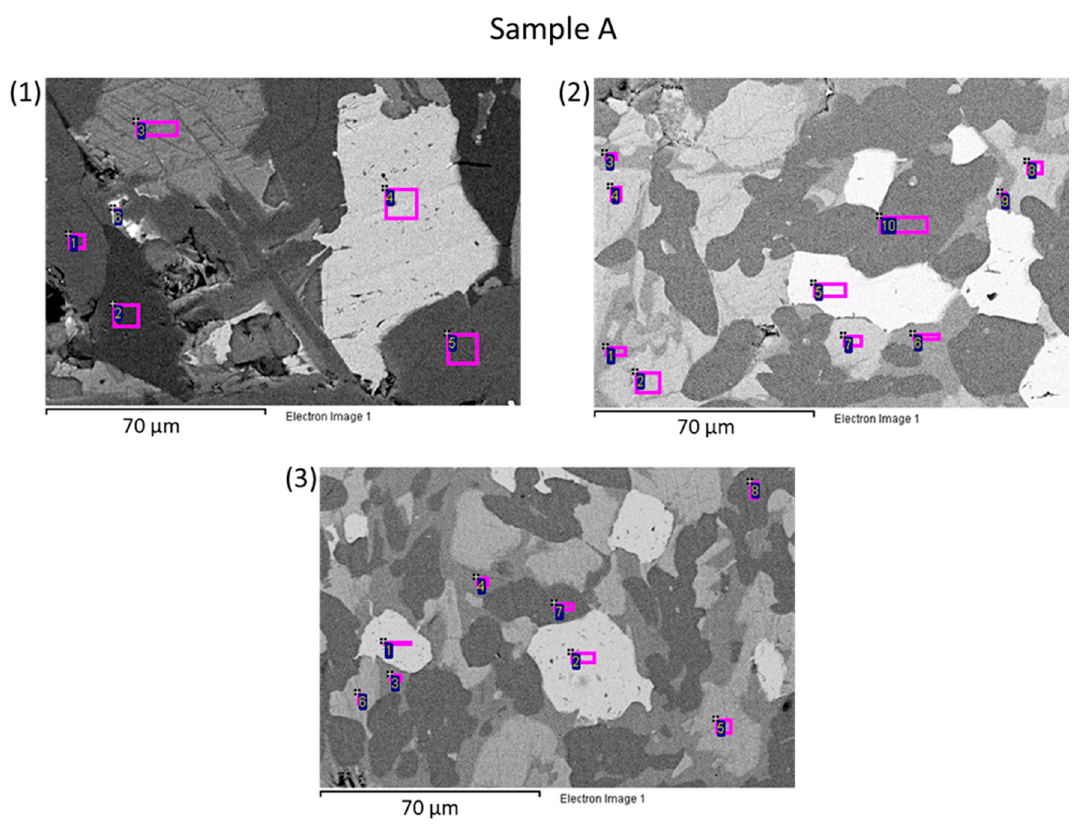
Figure 1. SEM micrographs of sample A performed in three different areas. EDXS measurements were collected in the squares. Table 3. EDXS analysis of sample A (molar%) in the points indicated in Figure 1 and the predicted crystalline phase.